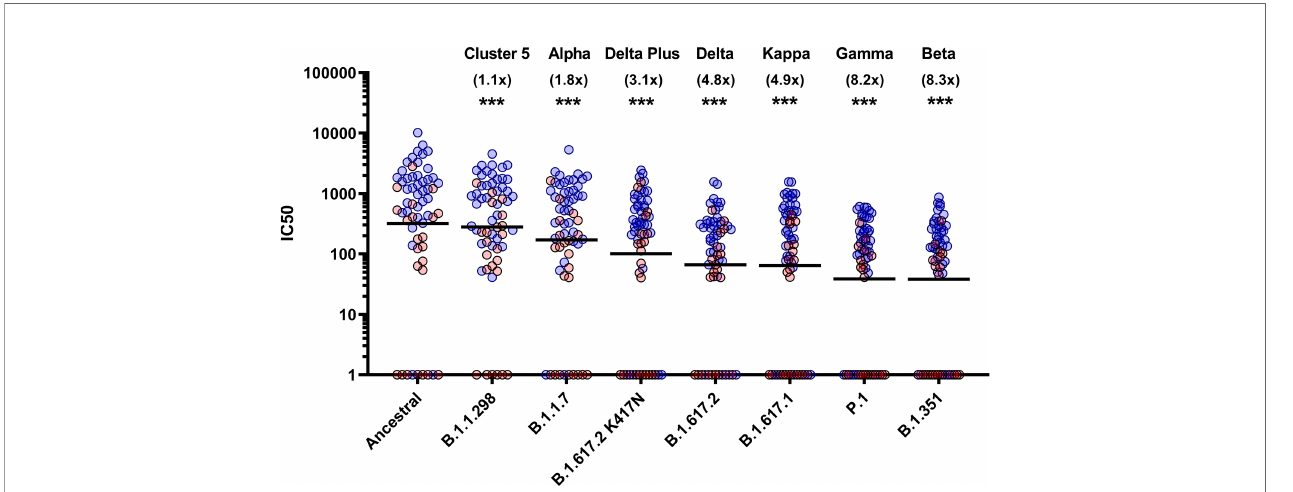
FIGURE 2 | Neutralisation of SARS-CoV-2 pseudotypes by convalescent Serum from seropositive hospital patients and health care workers. Neutralisation assays were carried out using pseudotypes expressing either ancestral spike or B.1.1.298, B.1.1.7, B.1.617.2 K417N, B.1.617.2, B.1.617.1, P.1 and B.1.351. Data is presented in order of increasing fold changes (values in brackets) against the ancestral strain, revealing that VOCs B.1.351 and P.1 have the largest fold decreases (8.2 and 8.3 fold decrease respectively. Wilcoxon signed rank tests were used for statistical analysis between ancestral strain and each VOC (p = <0.001). Black lines denote geometric means. Blue circles represent samples derived from patients, red circles represent samples derived from previously infected healthcare workers.